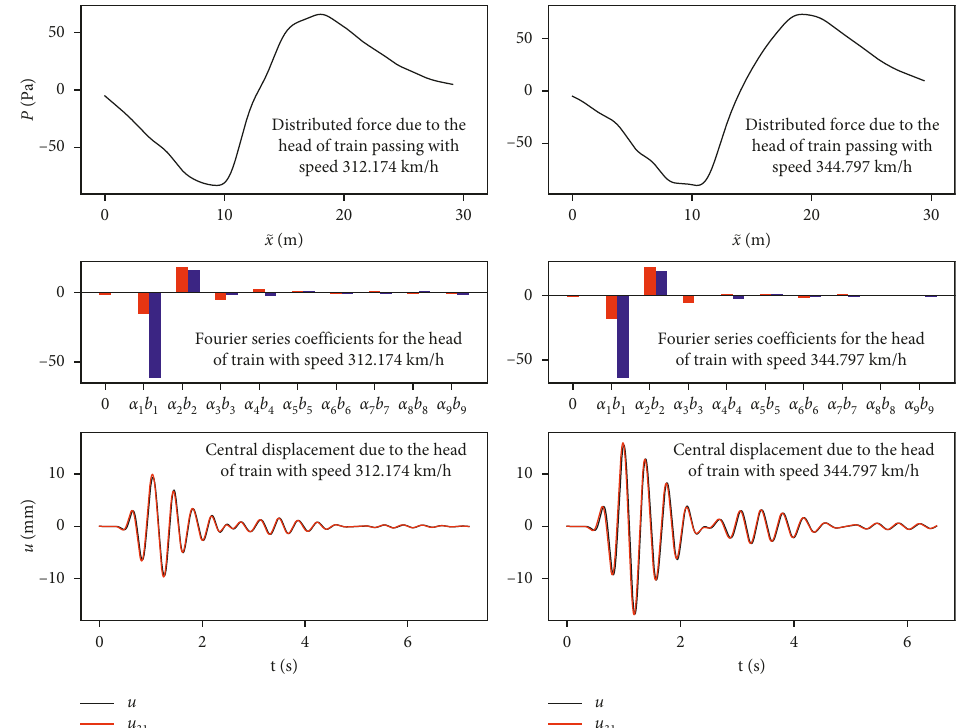
Figure 15: Comparisons of the distributed force, Fourier series coefficients, and central displacements of the fourth span of the purlin between the two high-speed trains ( u stands for the central displacement of the purlin under the distributed force due to the head of the train and u 31 stands for the central displacement of the purlin under the first sine wave decomposed from the distributed force due to the head of the